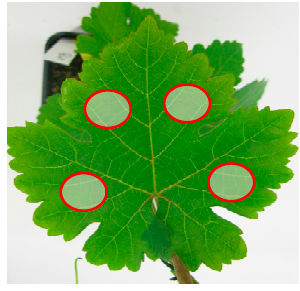
Figure 3. Locations of the measurements on a sample leaf.